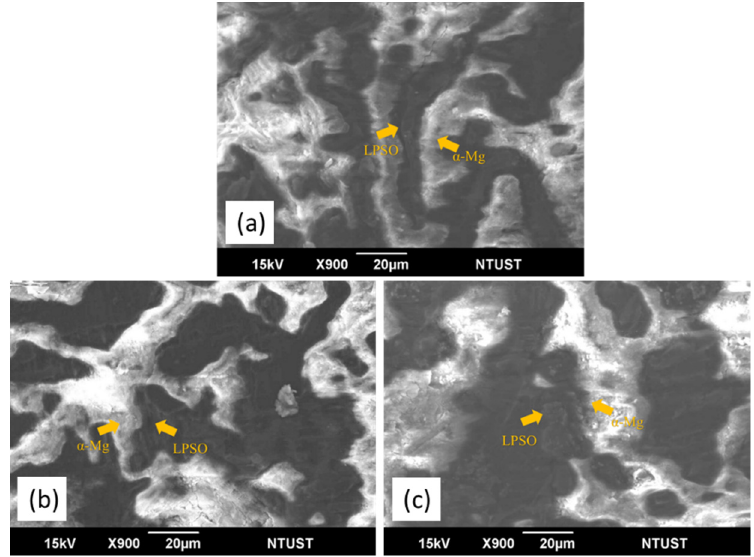
Figure 9. Surface morphology of WZ73 and MMCs after removing corrosion products: ( a ) WZ73; ( b ) WZ73-1.5 vol% SiC and ( c ) WZ73-2.5 vol% SiC.